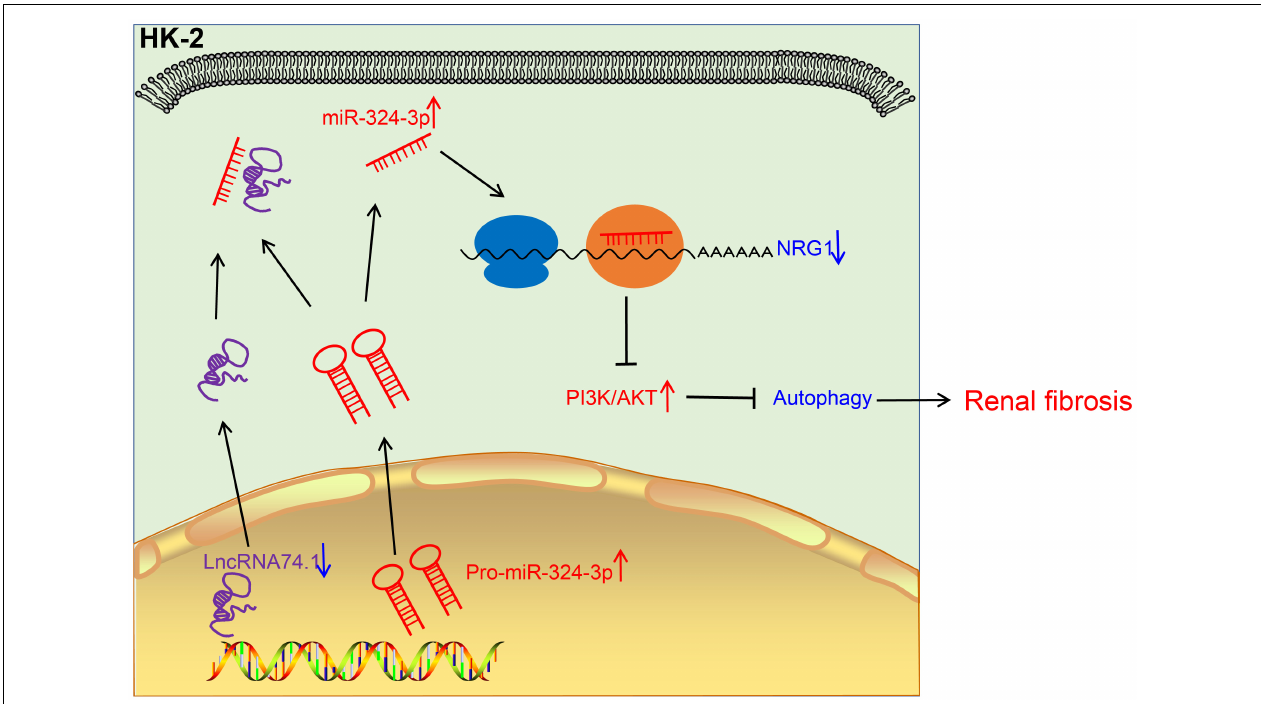
FIGURE 8 | The mechanistic diagram illustrating the role of lncRNA 74.1/miR-324-3p/NRG1-mediated PI3K/AKT signaling pathway in renal fibrosis. In renal fibrosis, lncRNA 74.1 expressed poorly and miR-324-3p expressed highly. LncRNA 74.1 could bind to miR-324-3p and negatively regulate its expression, which further promoted the NRG1 expression and inactivated the PI3K/AKT signaling pathway, thereby inducing cellular autophagy, and inhibiting renal